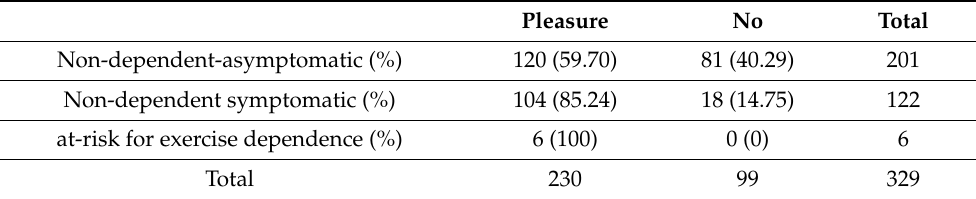
Table 6. Summary of cases